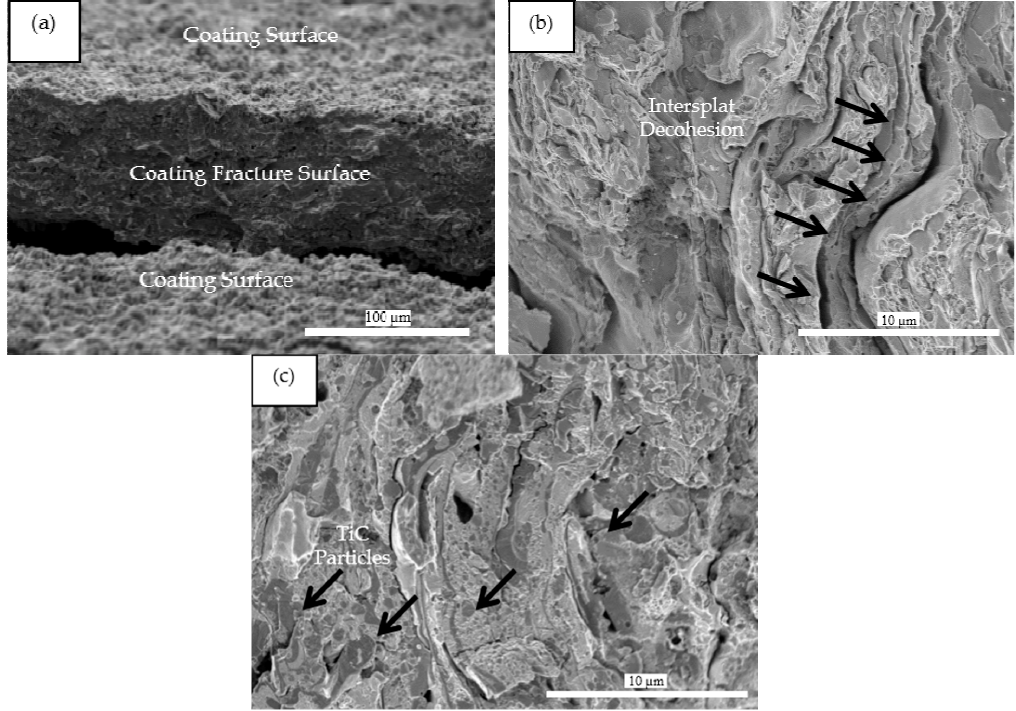
Figure 8. Fracture surface SEM images of thermally sprayed coatings: ( a ) a general profile, ( b ) unreinforced Fe 3 Al and ( c ) Fe 3 Al–50 vol. % TiC sample. Arrows in b show large decohesion at splat interfaces. Arrows in c show well bonded TiC particles in the Fe 3 Al matrix.